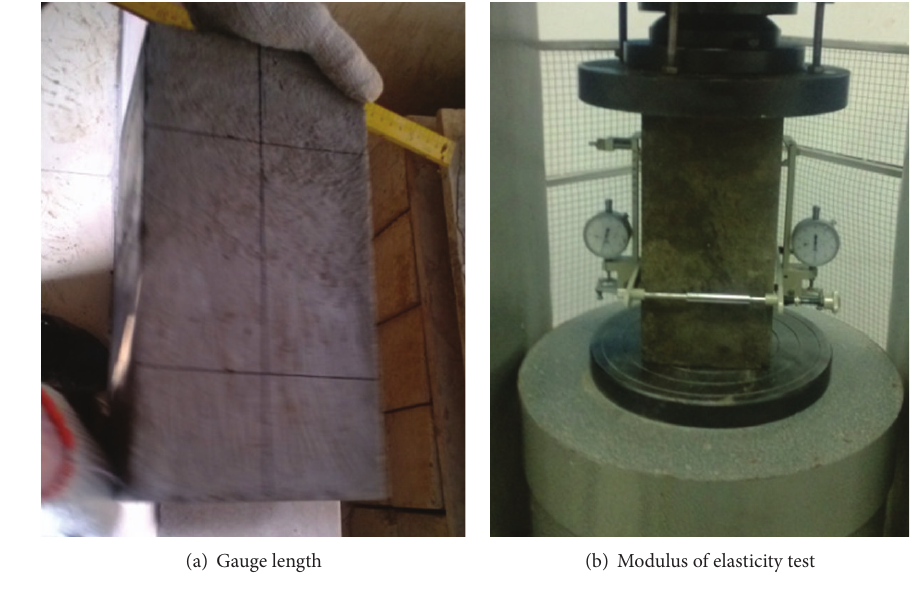
Figure 9: Testing arrangement of modulus of elasticity. Table 7: Change rate of the first order natural frequency (%).